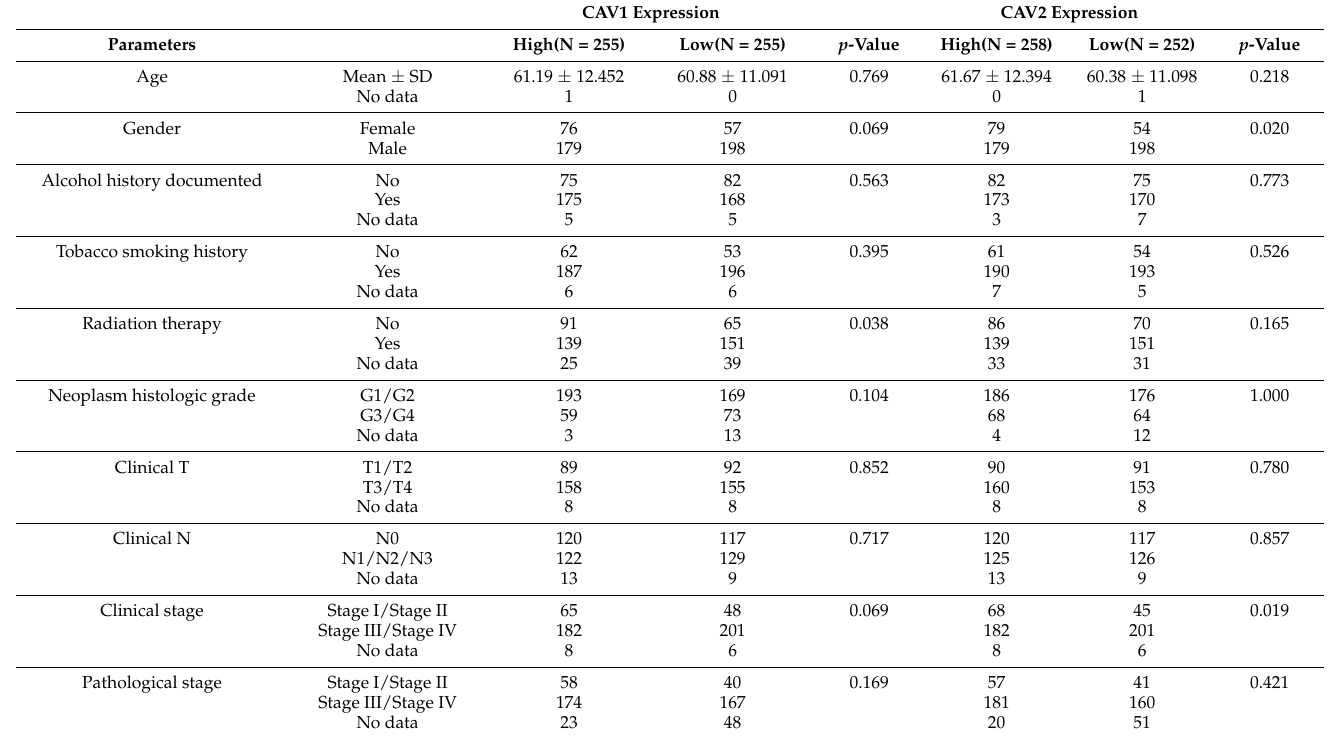
Table 1. Baseline information of the 510 patient